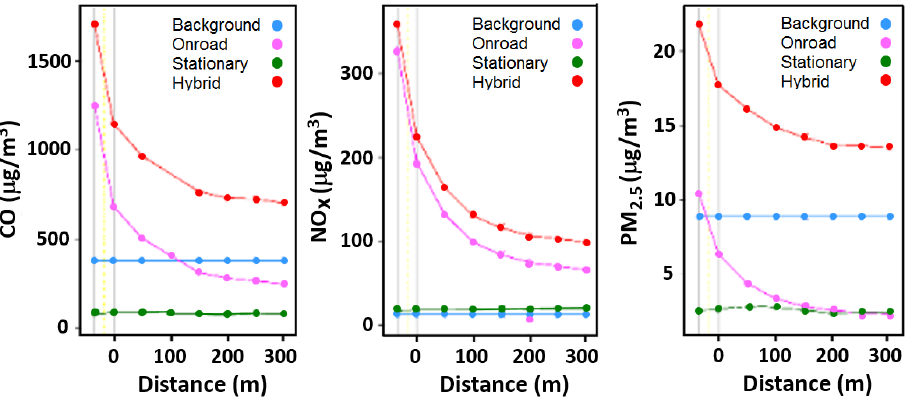
Figure 7. Near-road pollutant gradients of CO, NO average) from a mini-grid of 24 model receptors near the I-94